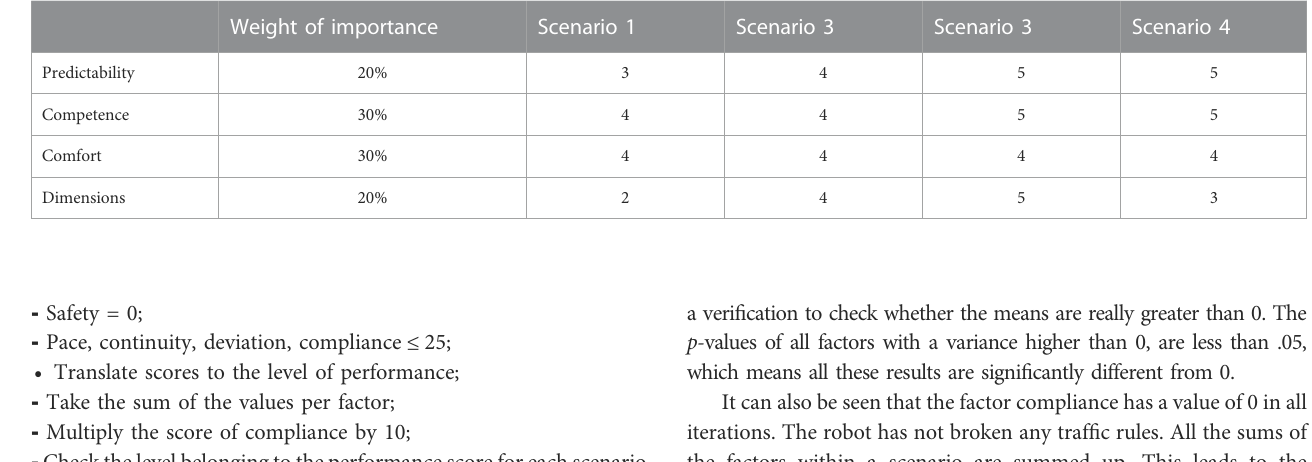
TABLE 9 Example of survey result by a